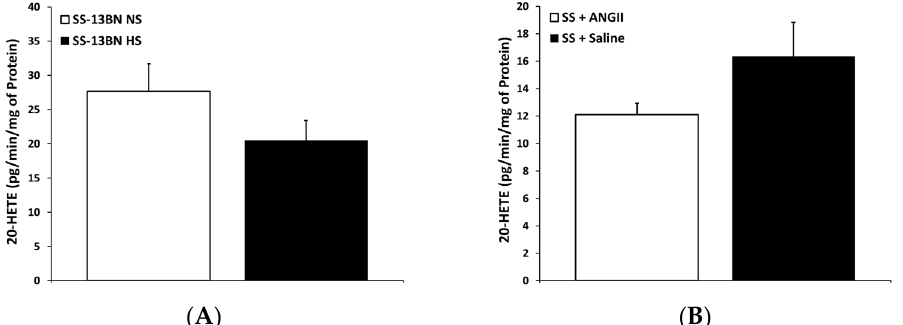
Figure 3. 20-HETE production in cerebral arteries from ( A ) normal-salt (NS)- and high-salt (HS)-fed SS-13 BN consomic rats and ( B ) SS rats fed high-salt diet with minipump delivery of either isotonic saline or angiotensin II (ANG II; 100 ng/kg/min). 20-HETE production assessed via LC-MS (n = 4–5 for all groups). Data are presented as amount of 20-HETE (pg) produced per minute per mg of pro- tein.